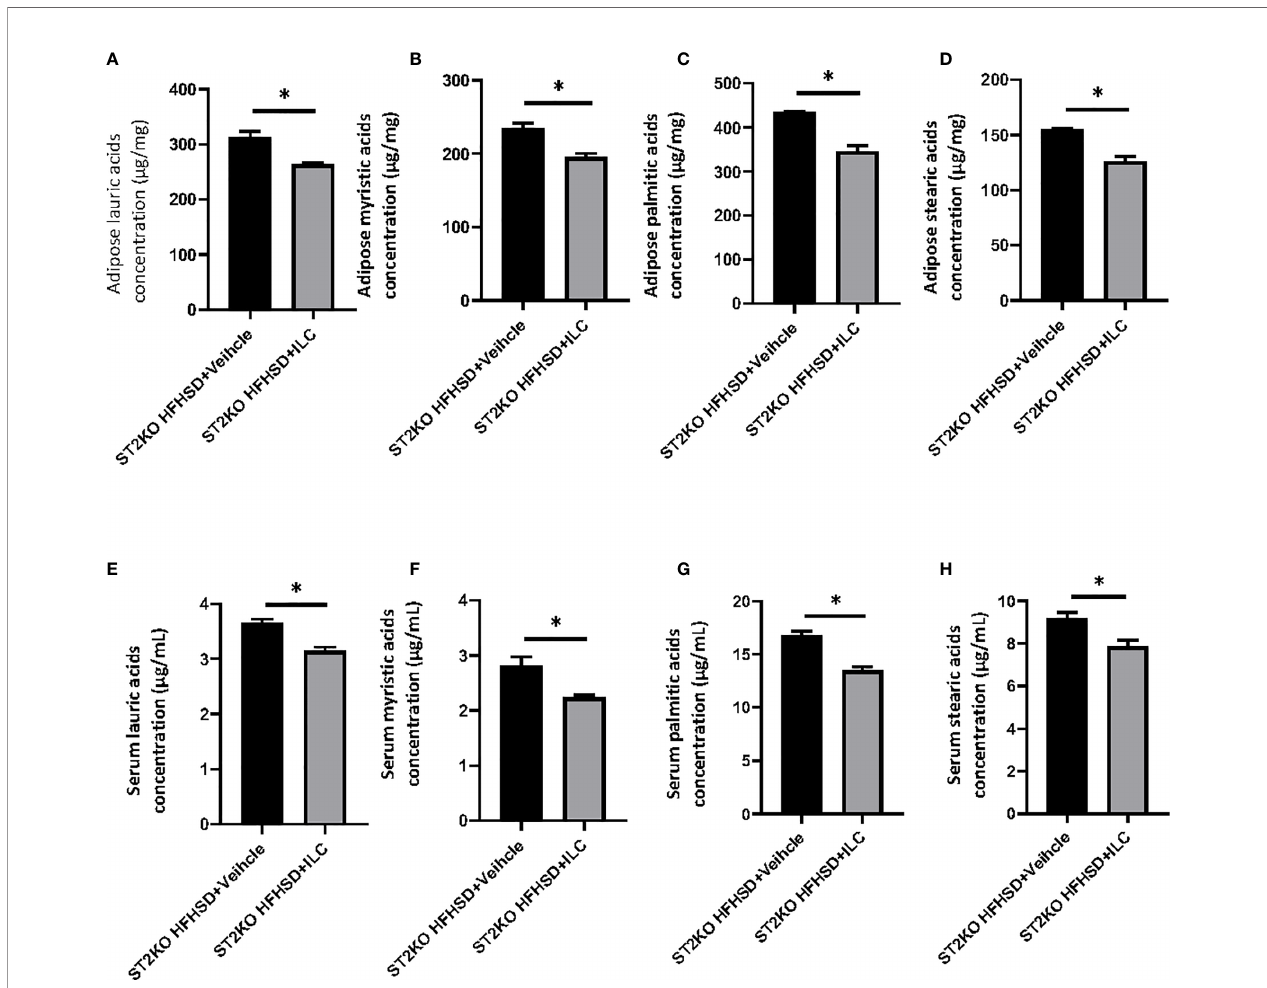
FIGURE 8 | Adoptive transfer of ILCs from WT mice bone marrow decreased saturated fatty acids in ST2KO mice. (A) Adipose lauric acids concentration (µg/mg). (B) Adipose myristic acids concentration (µg/mg). (C) Adipose palmitic acids concentration (µg/mg). (D) Adipose stearic acids concentration (µg/mg). (E) Serum lauric acids concentration (µg/mL). (F) Serum myristic acids concentration (µg/mL). (G) Serum palmitic acids concentration (µg/mL). (H) Serum stearic acids concentration (µg/mL). Data are represented as mean±SD; *p < 0.05 by One-way ANOVA